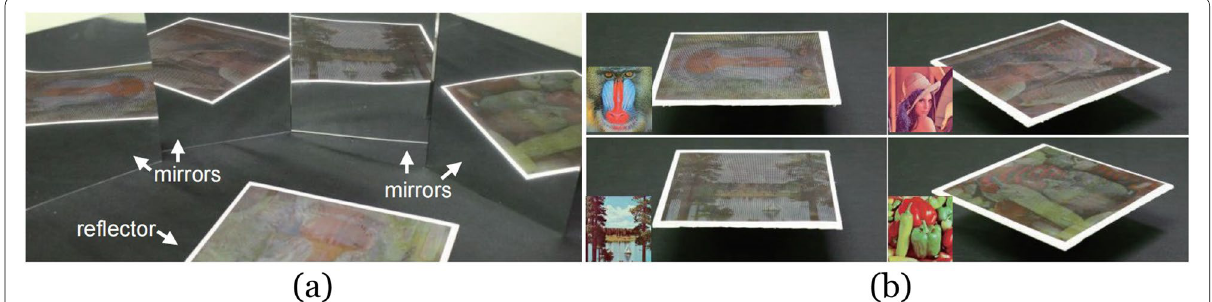
Fig. 15 a The user can see different images when viewing the object generated by Sakurai et al. [27] through mirrors. b The result of viewing the object at different